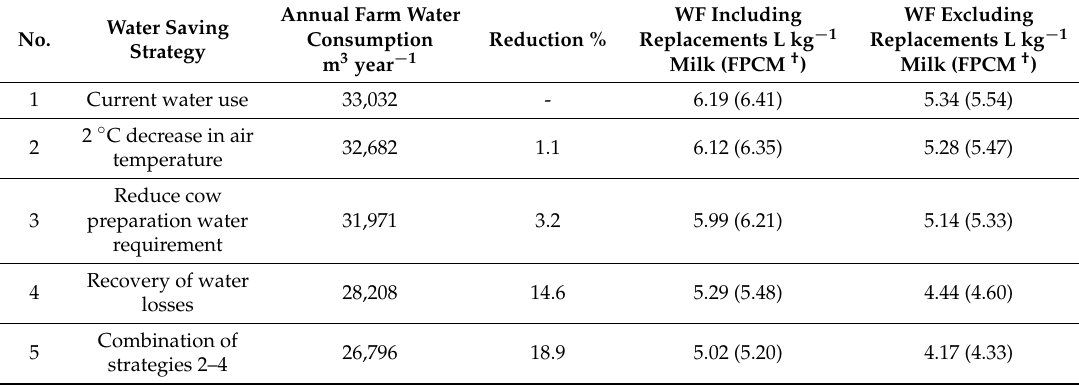
Table 4. Theoretical water conservation scenarios and their expected effect on milk production water footprint